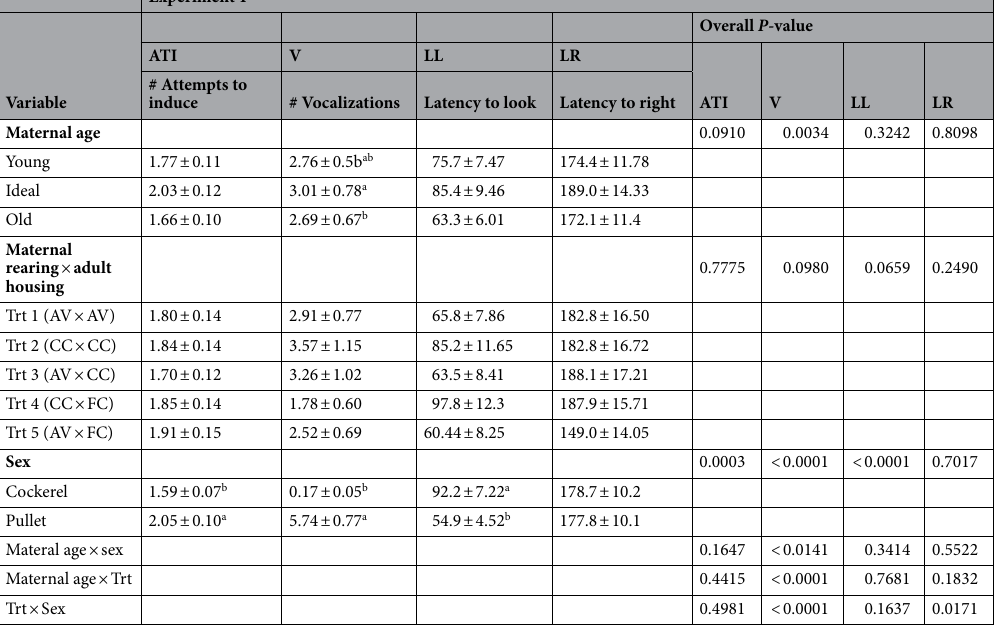
Table 4. Means ± SEM for number of attempts to induce, number of vocalizations, latency to look, and latency to right during a tonic immobility test conducted on progeny from Experiment 1 at 9 weeks of age. ab Values within a column for Maternal Age and Sex with different superscripts differ P <